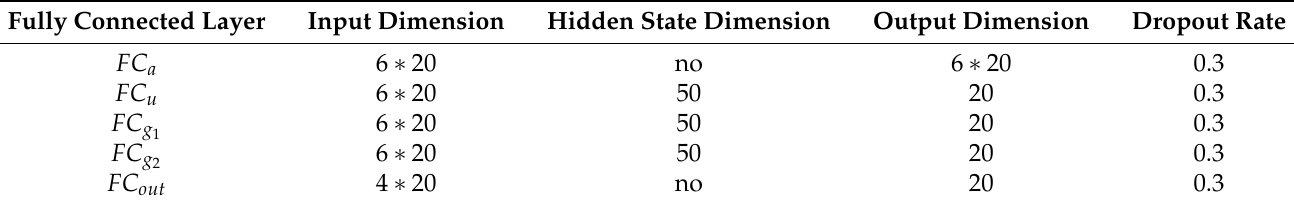
Table 1. The hyper parameters of fully connected layers in the